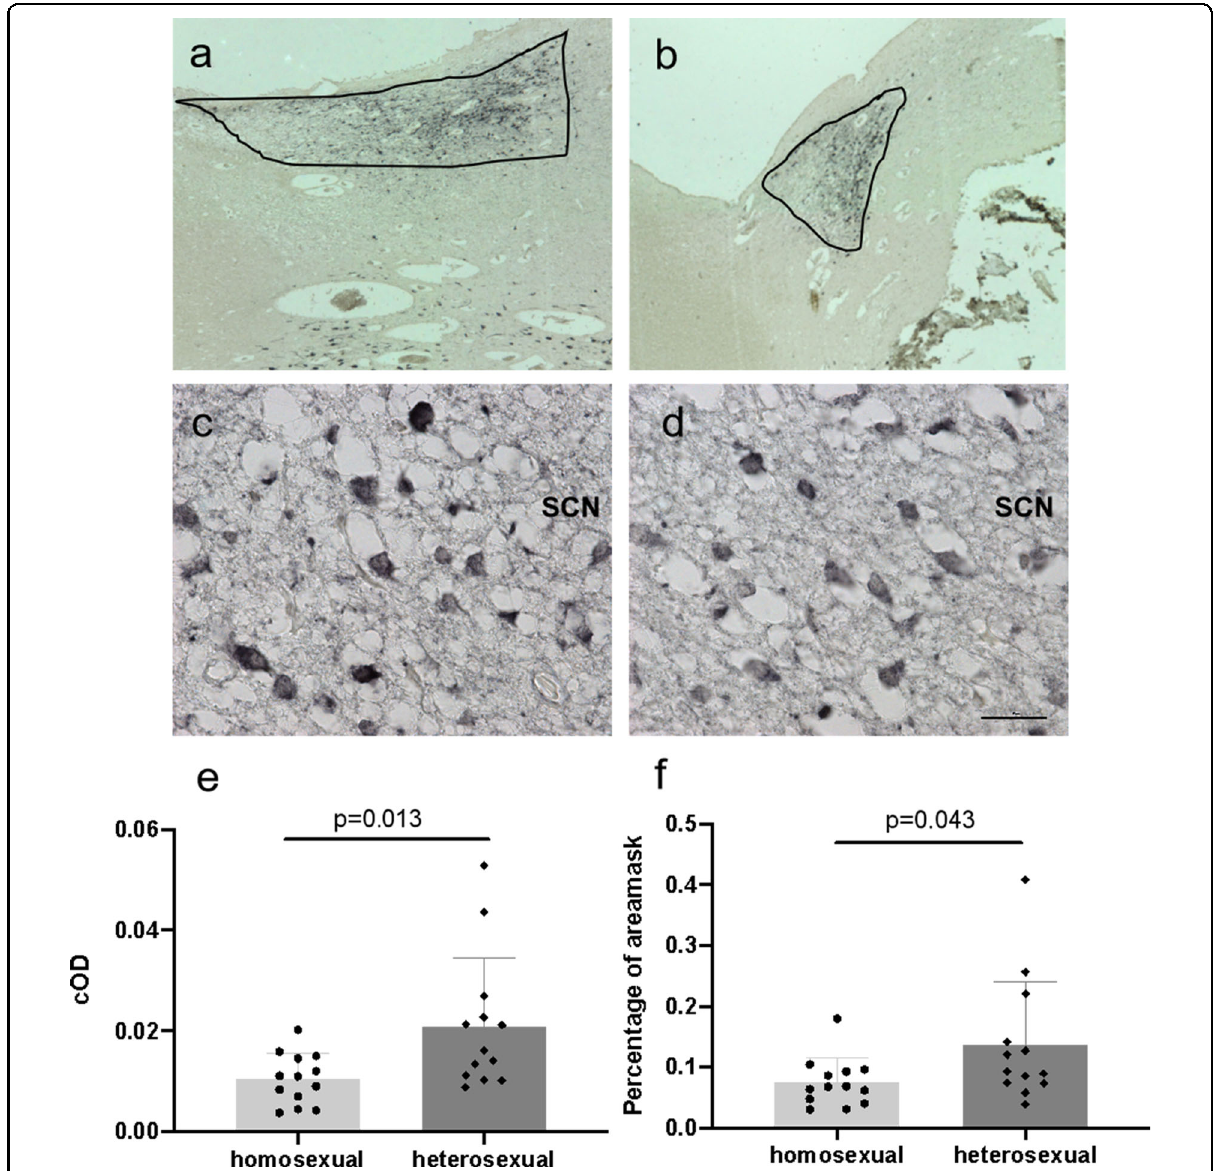
Fig. 3 Postmortem study of ZNF536 . a , b AVP-immunoreactivity (AVP-ir) is identi fi ed in the SCN of a homosexual man ( a ) and a heterosexual man ( b ). c , d ZNF536-immunoreactivity (ZNF536-ir) of a heterosexual man ( c ) and a homosexual man ( d ) in the area of the SCN. Data are presented as the means ± SEM. e , f The cOD of ZNF536 was signi fi cantly lower level in homosexual subjects ( n = 13) than in heterosexual subjects ( n = 13) ( e ), and the percentage of stained area was relatively smaller in homosexual subjects ( f